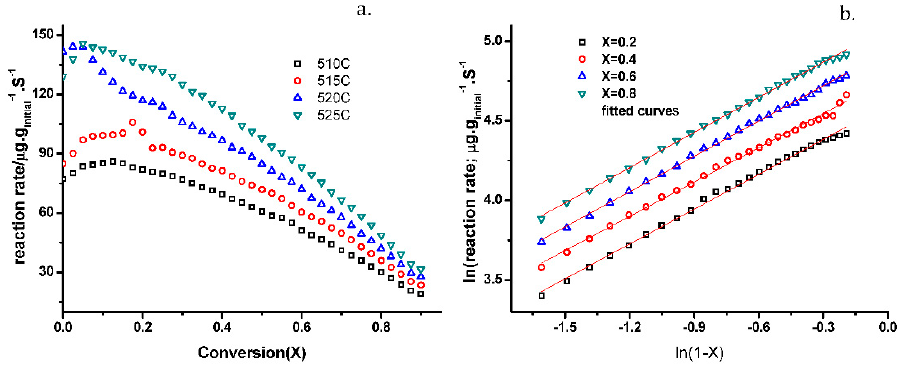
Figure 8. ( a ) Oxidation rate of flame soot FS100 vs. conversion as a function of temperature; ( b ) Linear fitting of reaction order in carbon for flame soot FS100.